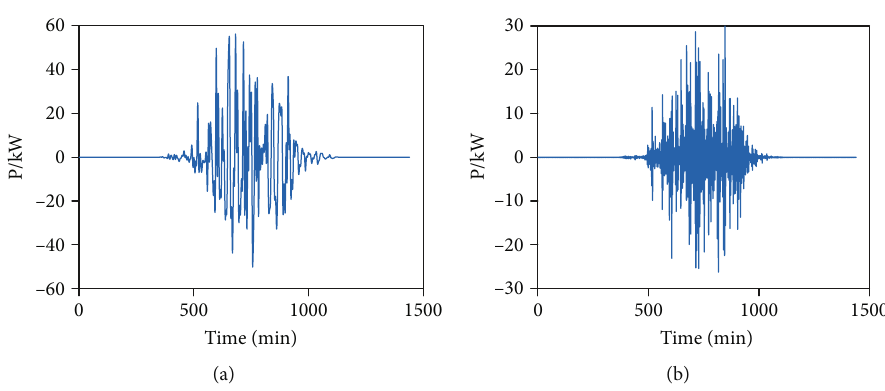
Figure 12: Hybrid energy storage power curve. (a) Battery power. (b) Supercapacitor